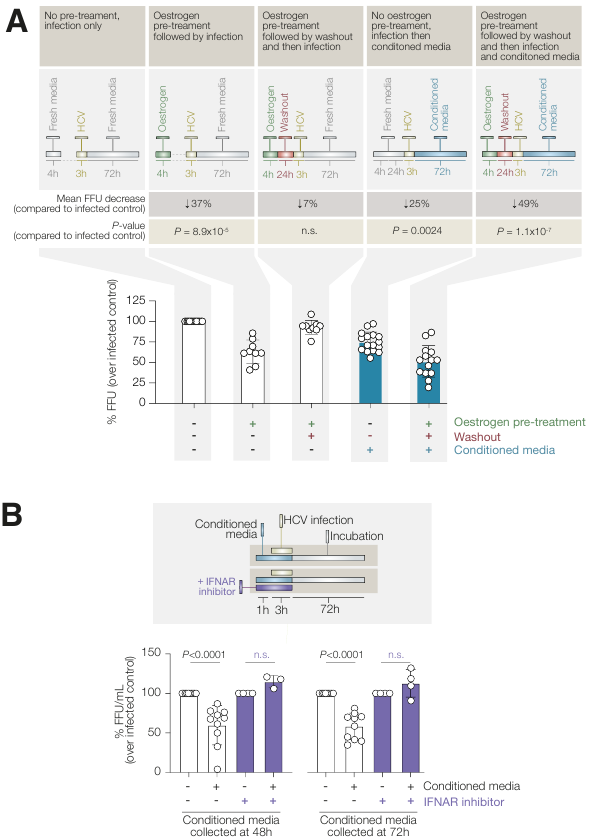
Figure 4. Oestrogen-conditioned supernatant is essential for antiviral activity. ( A ) HuH7 cells with or without 4 h oestrogen pre-treatment were infected with HCV. Infection occurred either immediately post-oestrogen treatment or following a 24 h of washout period with fresh media. Infected cells were then cultured in either conditioned media collected at 24 h or fresh media. Antiviral activity was evaluated at 72 h post infection by FFU assay. Statistical significance was evaluated by Kruskal–Wallis one-way analysis of variance with Dunn’s p value correction. ( B ) HuH7 cells were treated with CM 48 or CM 72 for 1 h with or without IFNARi, followed by infection in the presence of indicated treatments. Cells were then incubated in fresh media for 72 h, and the extracellular viral titre (FFU/mL) was evaluated through FFU assay. Data represent the mean and SEM of at least 3 independent experiments with 2 biological replicates. Statistical significance was evaluated by Mann–Whitney U test. n.s.: not